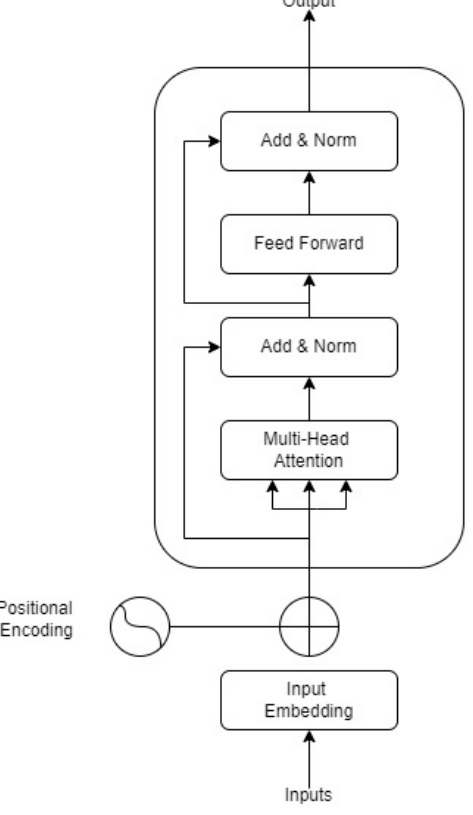
Figure 1. Simple Transformer encoder.